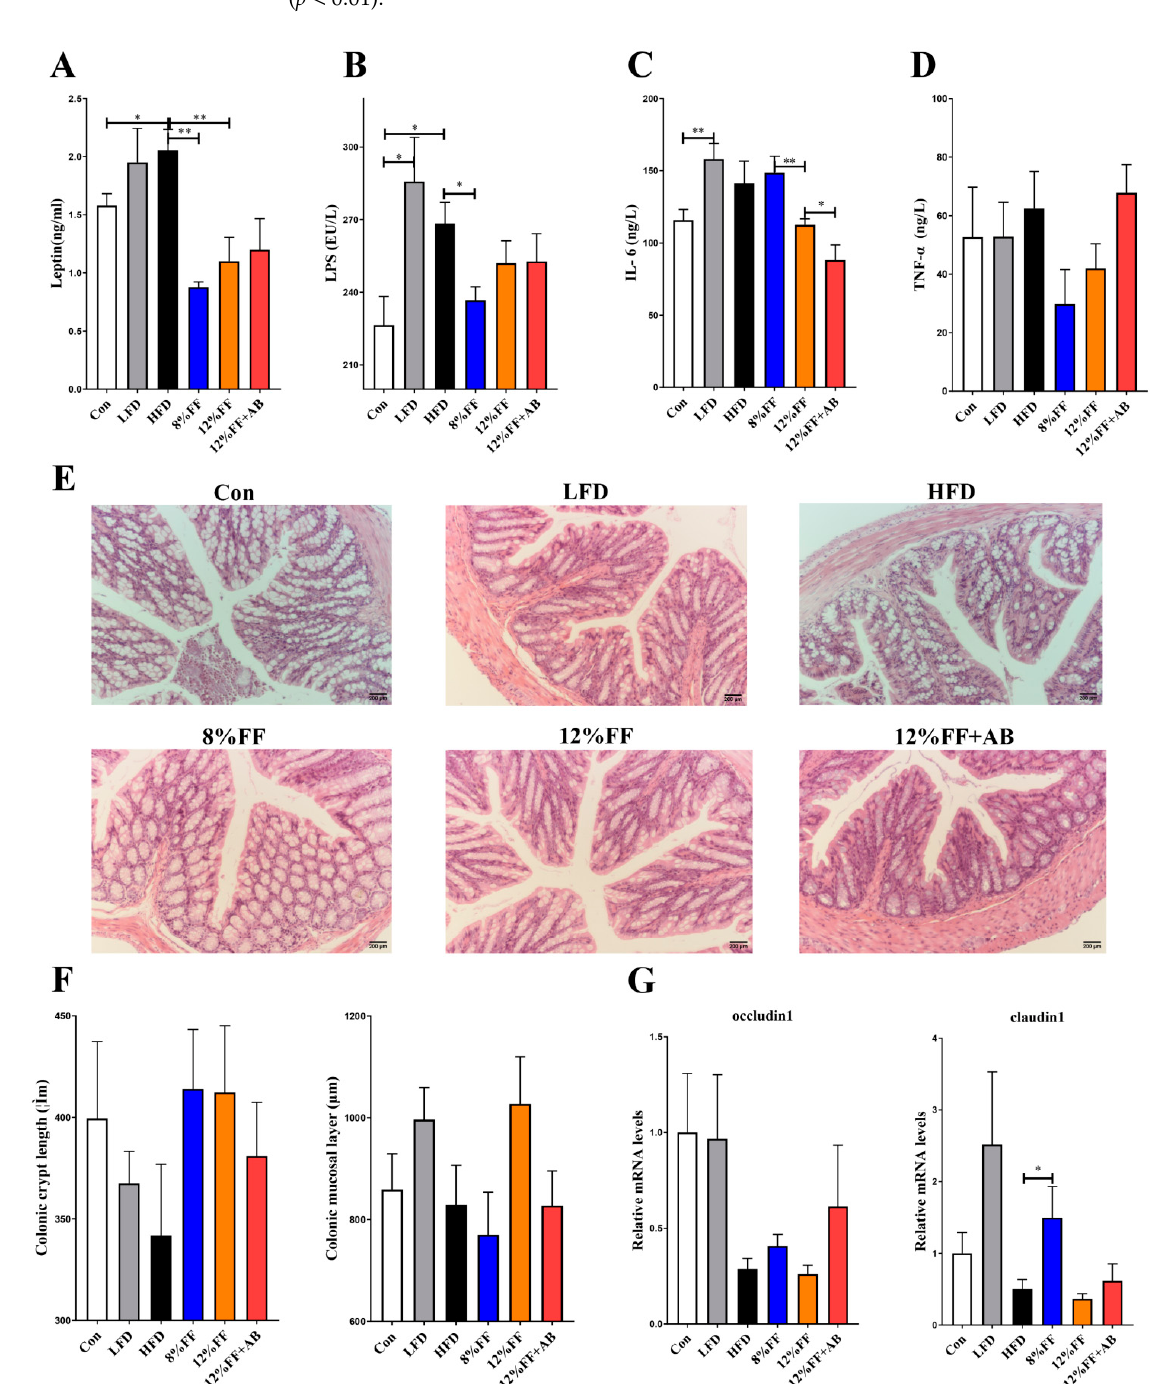
Figure 3. Effects of functional fiber on inflammatory indexes, gut health, and barrier integrity of obese mice ( n = 7). ( A ) Leptin. ( B ) Lipopolysaccharide (LPS). ( C ) Tumor necrosis factor- α (TNF- α ). ( D ) IL-6. ( E ) The H&E-stained images of colon tissue (magnification: 200). ( F ) Depth of colonic crypts and thickness of mucosal layer. ( G ) The mRNA expression of colonic tight junction protein gene occludin 1 and Claudin-1 . The results are shown as the mean ± SEM. Significant differences are expressed as * ( p < 0.05), and extremely significant differences are expressed as ** ( p < 0.01).